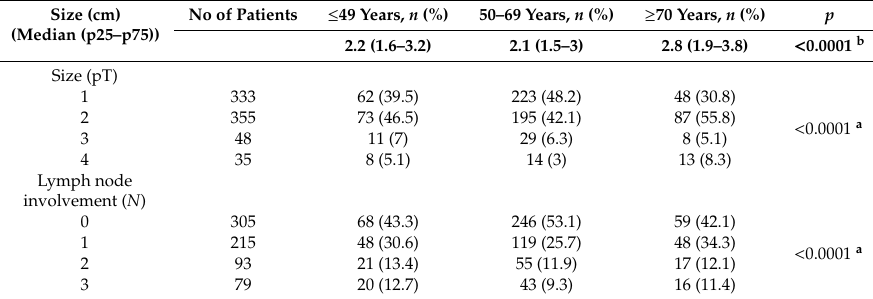
Table 1. Pathologic features of breast carcinomas according to